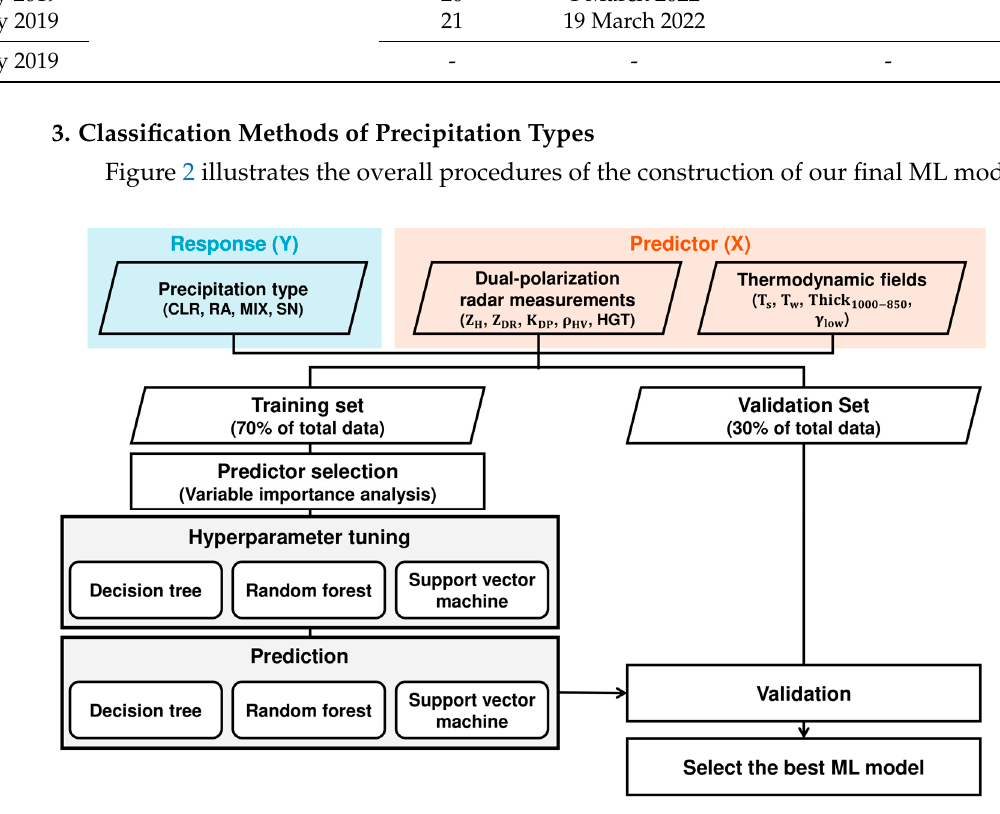
Table 1. List of precipitation events for training, validation, and application.